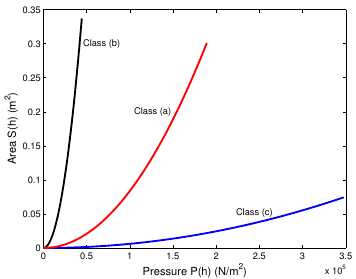
Figure 4. The relationship of pressure and cross-sectional area for species (a),(b) and (c). From these simulation results, we see that the maximum of the intensity of pressure for unit area is class (c), then class (a) and (b) is minimum. Thus there is a hidden relationship between the hardness and the leaf